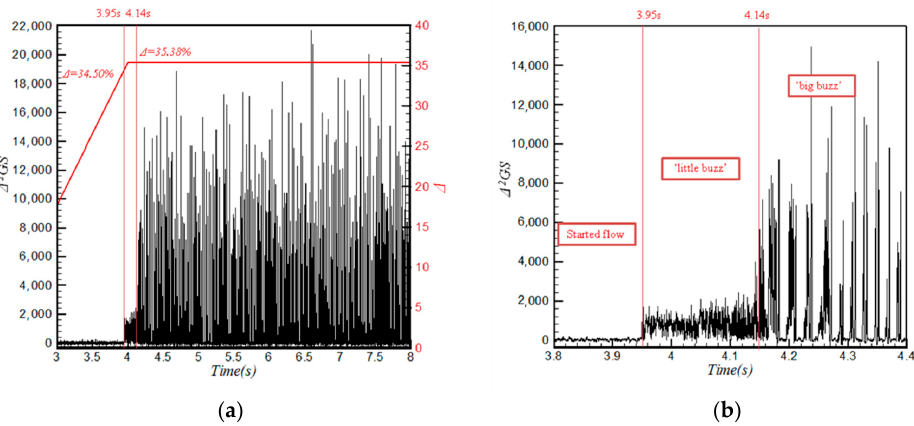
Figure 9. Grayscale time history of line L (( a ) t = 3–8 s; ( b ) t = 3.8–4.4 s).